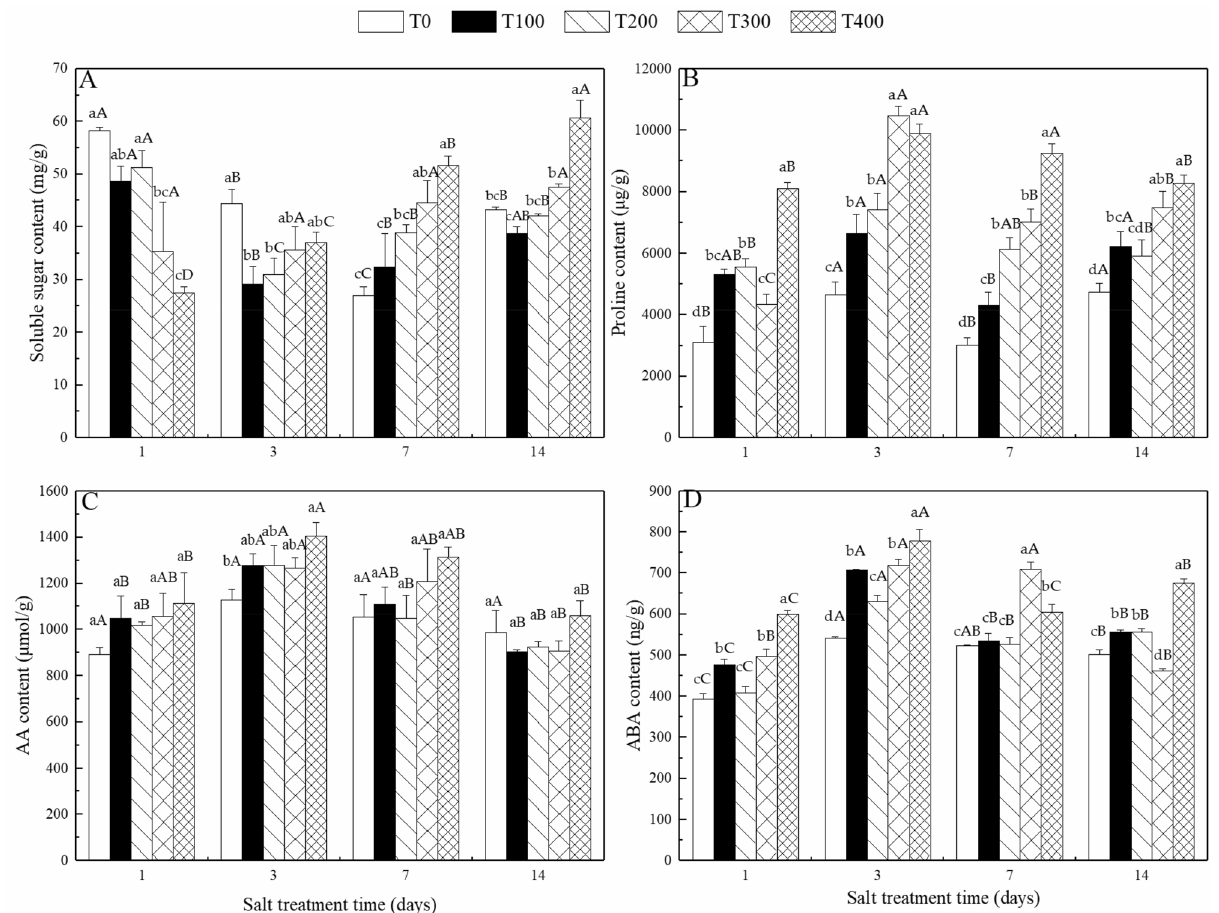
Figure 1. Soluble sugar ( A ), proline ( B ), amino acid ( C ) and ABA contents ( D ). Values represent the means ± SDs of three replicates, and the different small letters on histogram represent significant difference at P < 0.05 among different NaCl concentrations, while different capital letters represent significant difference at P < 0.05 among different treatment time in same NaCl